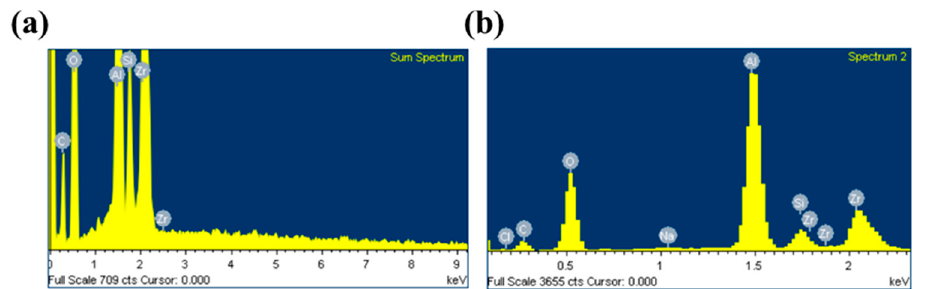
Figure 7. Composition (atomic concentration) of the cross-section: ( a ) virgin membrane; ( b ) fouled membrane. Table 2. The element composition of the virgin membrane.